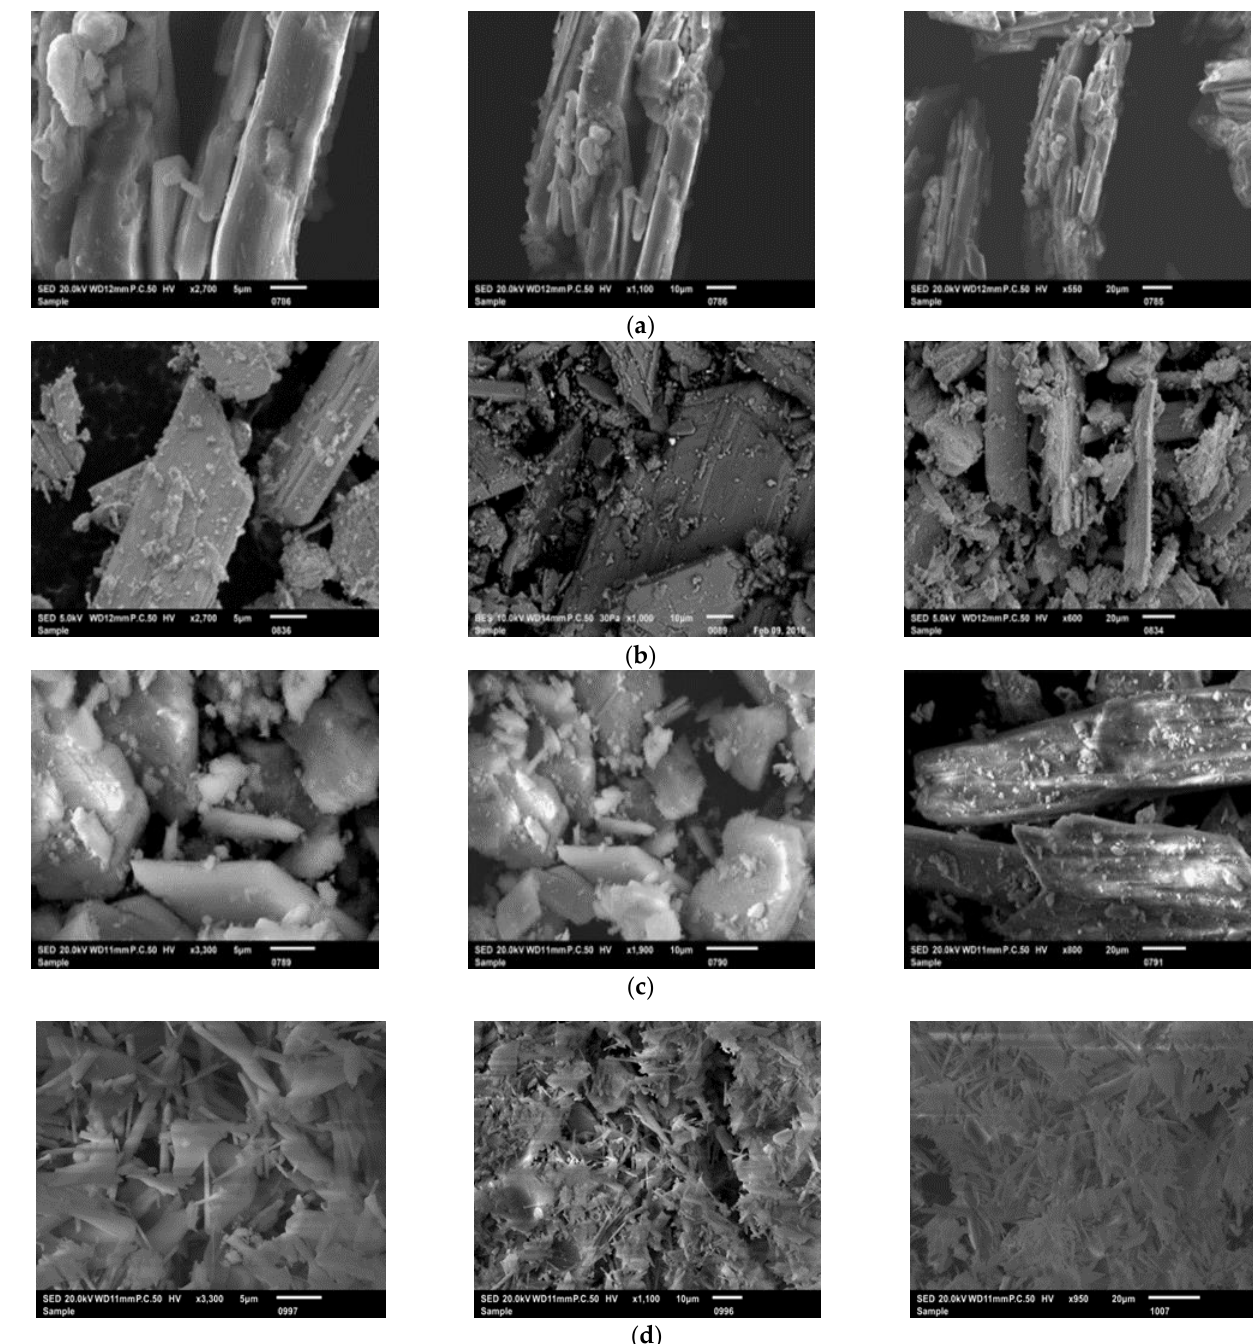
Figure 6. SEM micrographs of: PGF ( a ), PGW ( b ), PGT ( c ) and PGM ( d ).